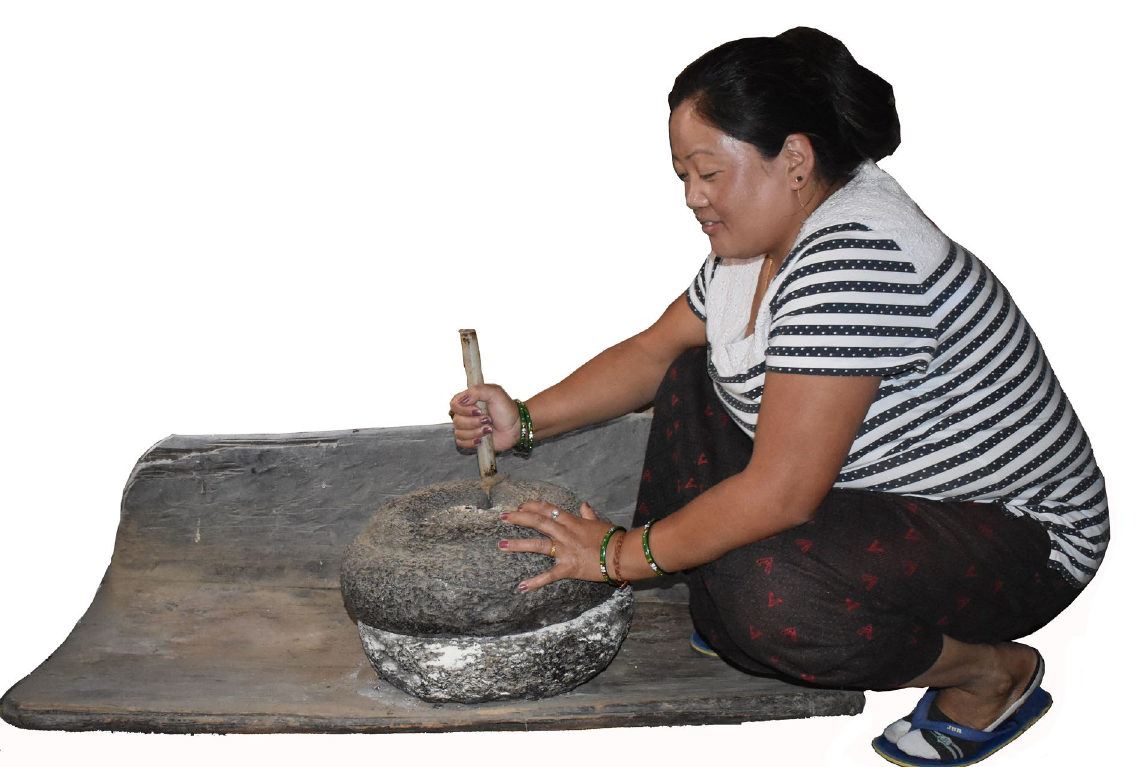
Figure 5. Shertukpen woman grinding millet using Ran-thok (Photo by N. J.